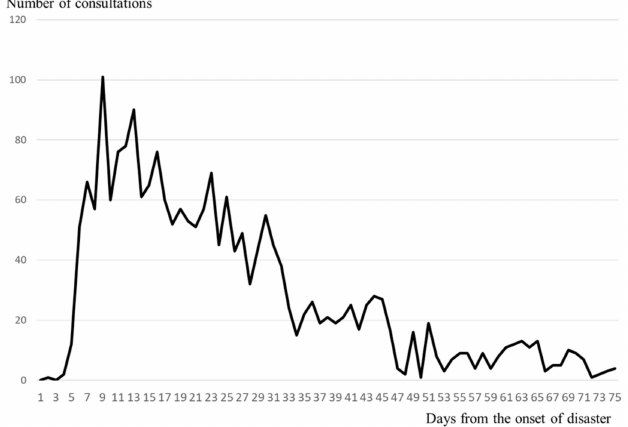
Figure 5. Change over time in the correspondence count per day for the Kumamoto